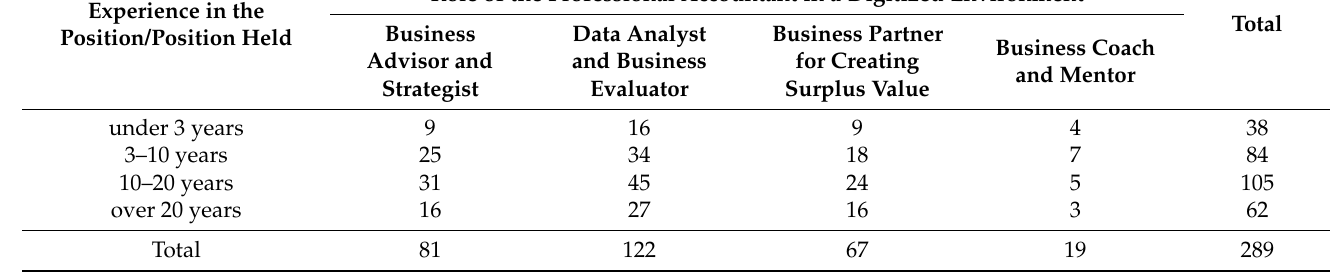
Table 15. The correlation between the experience in the position/position held and the role of the professional accountant in a digitized